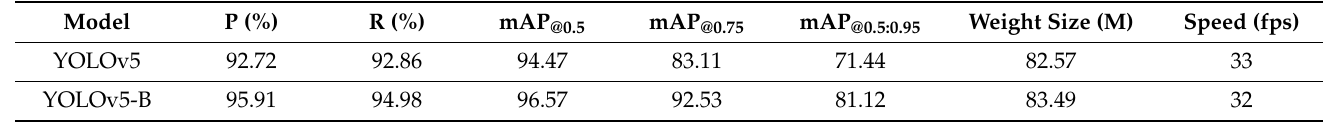
Table 4. Results of the improved neck